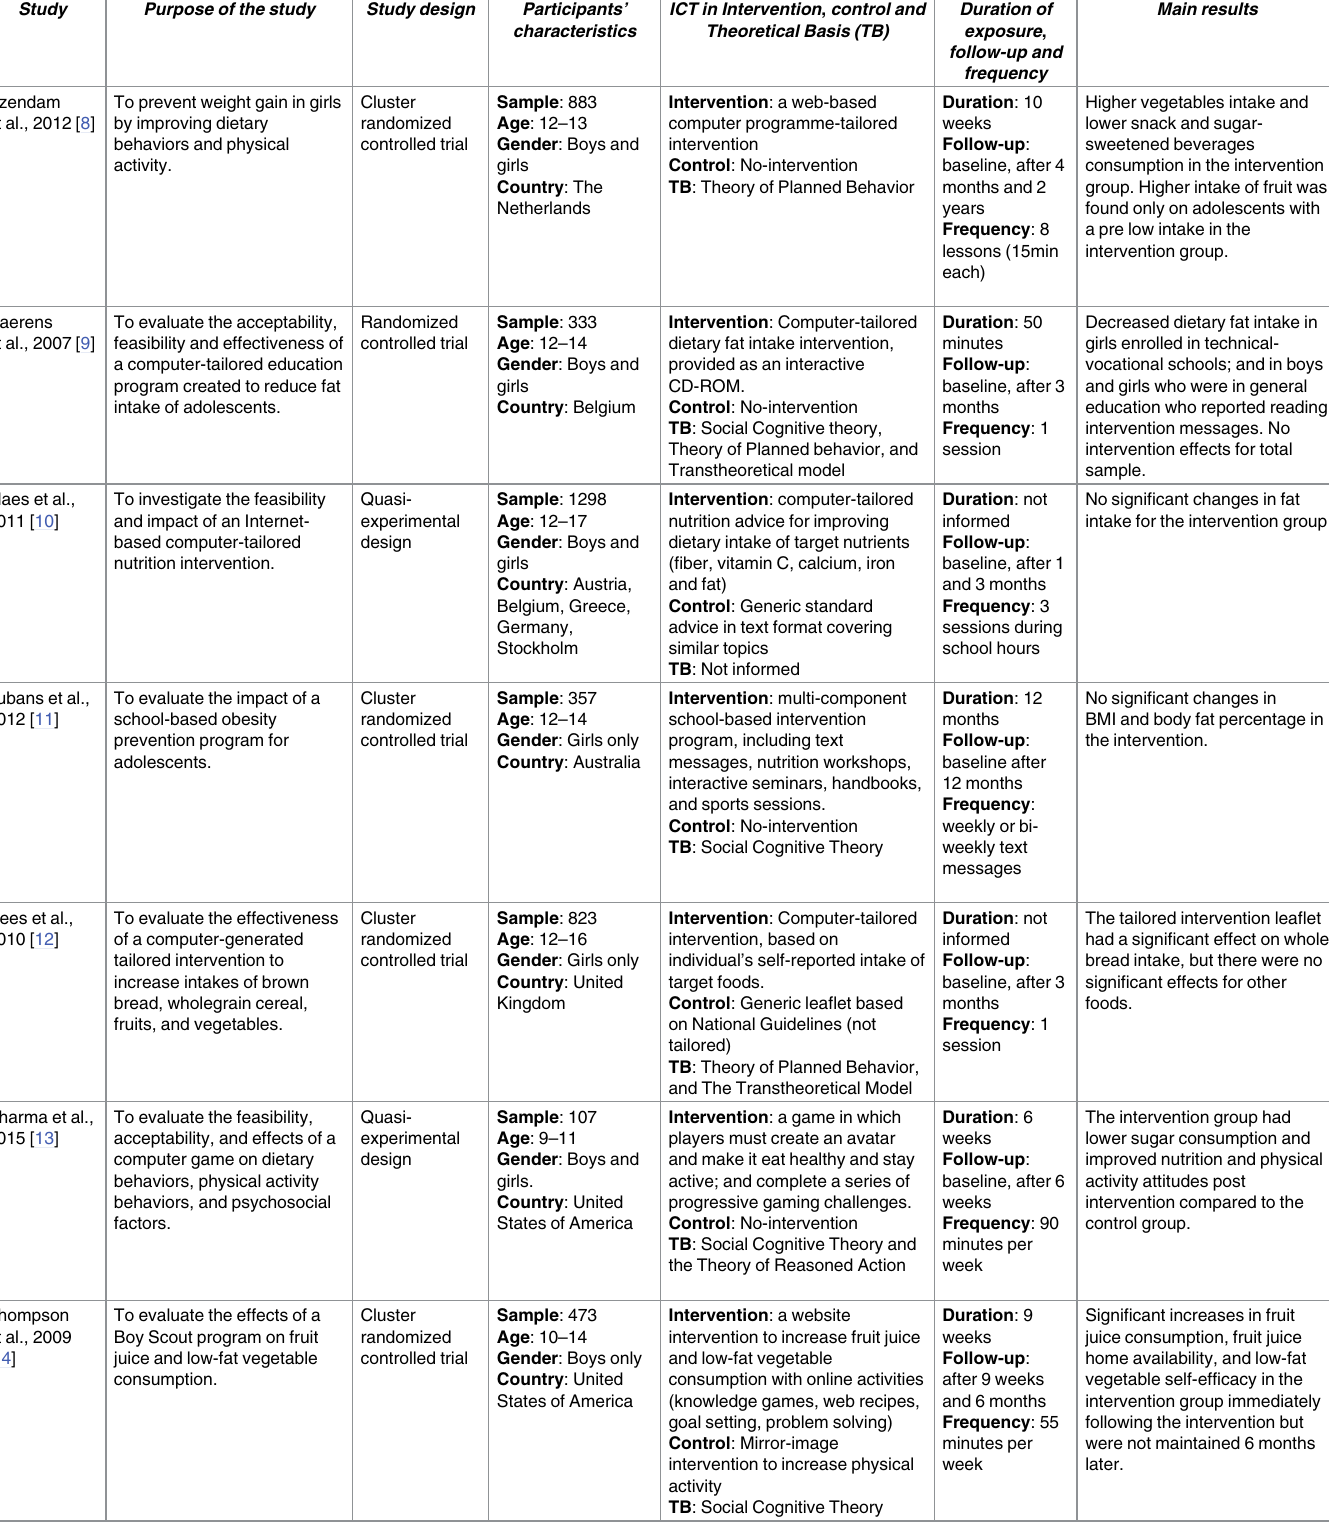
Table 1. Main characteristics of included